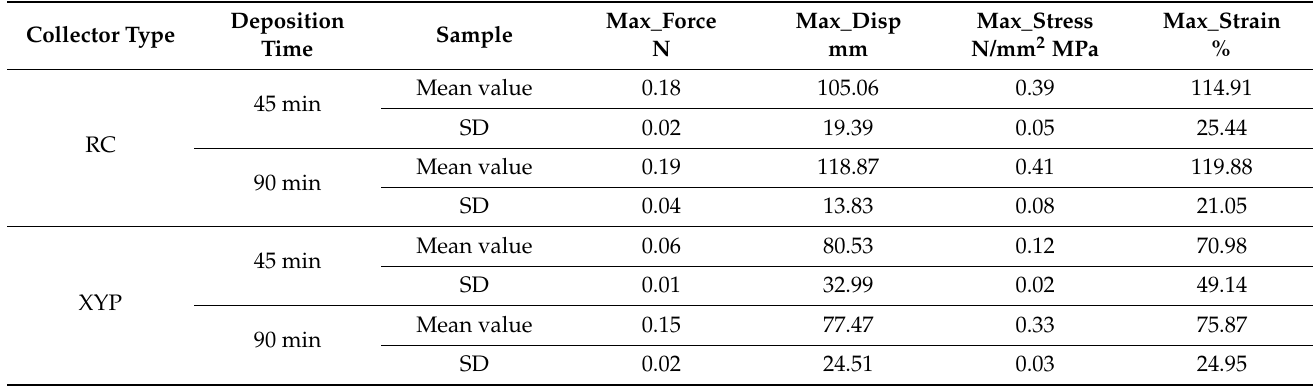
Table 2. Mechanical testing results of PCL